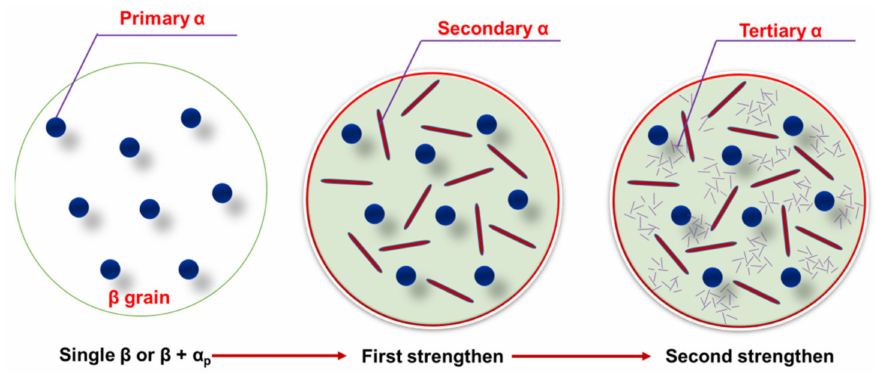
Figure 8. Sketch map of duplex-aging-strengthened β titanium alloy.